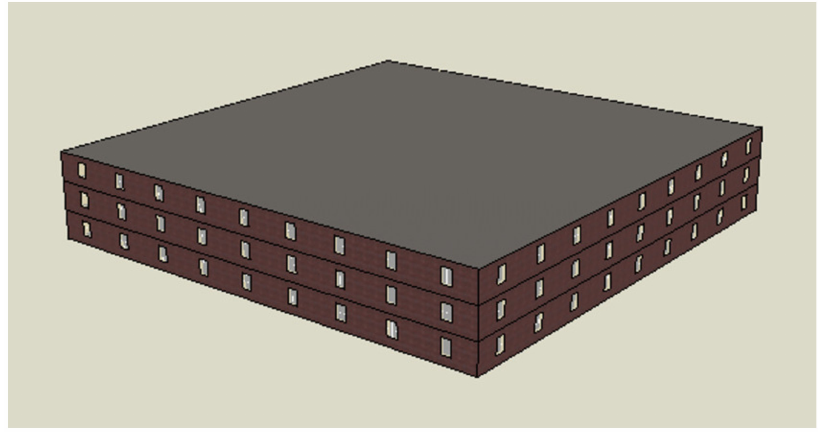
Figure 9. Prototypical building model in